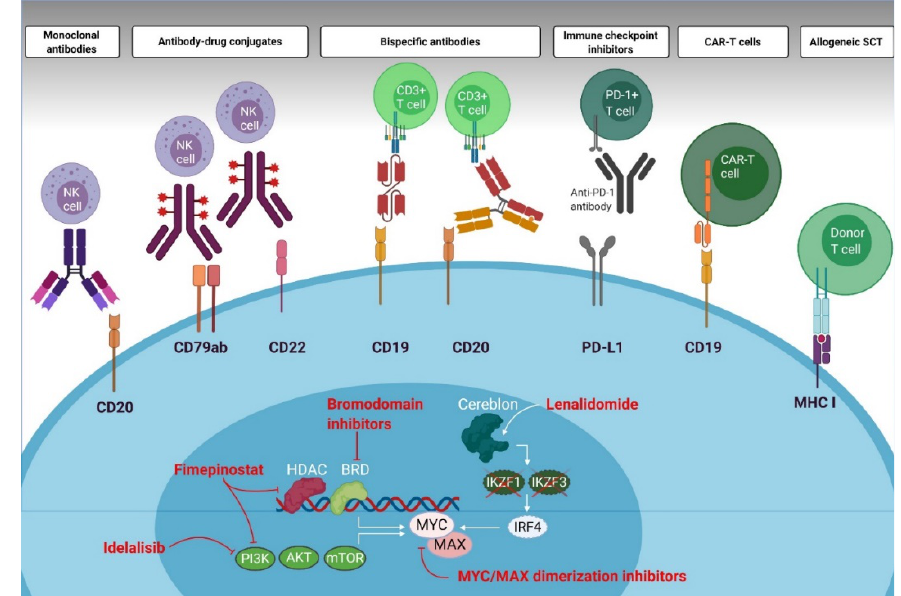
Figure 3. Immunotherapeutic treatment strategies and clinically available MYC modulators in lymphoid malignancies. Antibody-mediated therapies include monoclonal antibodies, antibody-drug conjugates, bispecific antibodies and immune checkpoint inhibitors. Cellular therapies include CAR-T cell therapy and allogeneic stem cell transplantation. Clinically available MYC modulators are lenalidomide (which reduces MYC protein by stimulating Cereblon, subsequently degrading IKZF1 and IKZF3, followed by downregulation of IRF4), idelalisib (PI3K inhibitor) and fimepinostat (combined PI3K and HDAC inhibitor). Preclinical MYC modulators are bromodomain (BRD) inhibitors (e.g., JQ1) and MYC / MAX dimerization inhibitors.